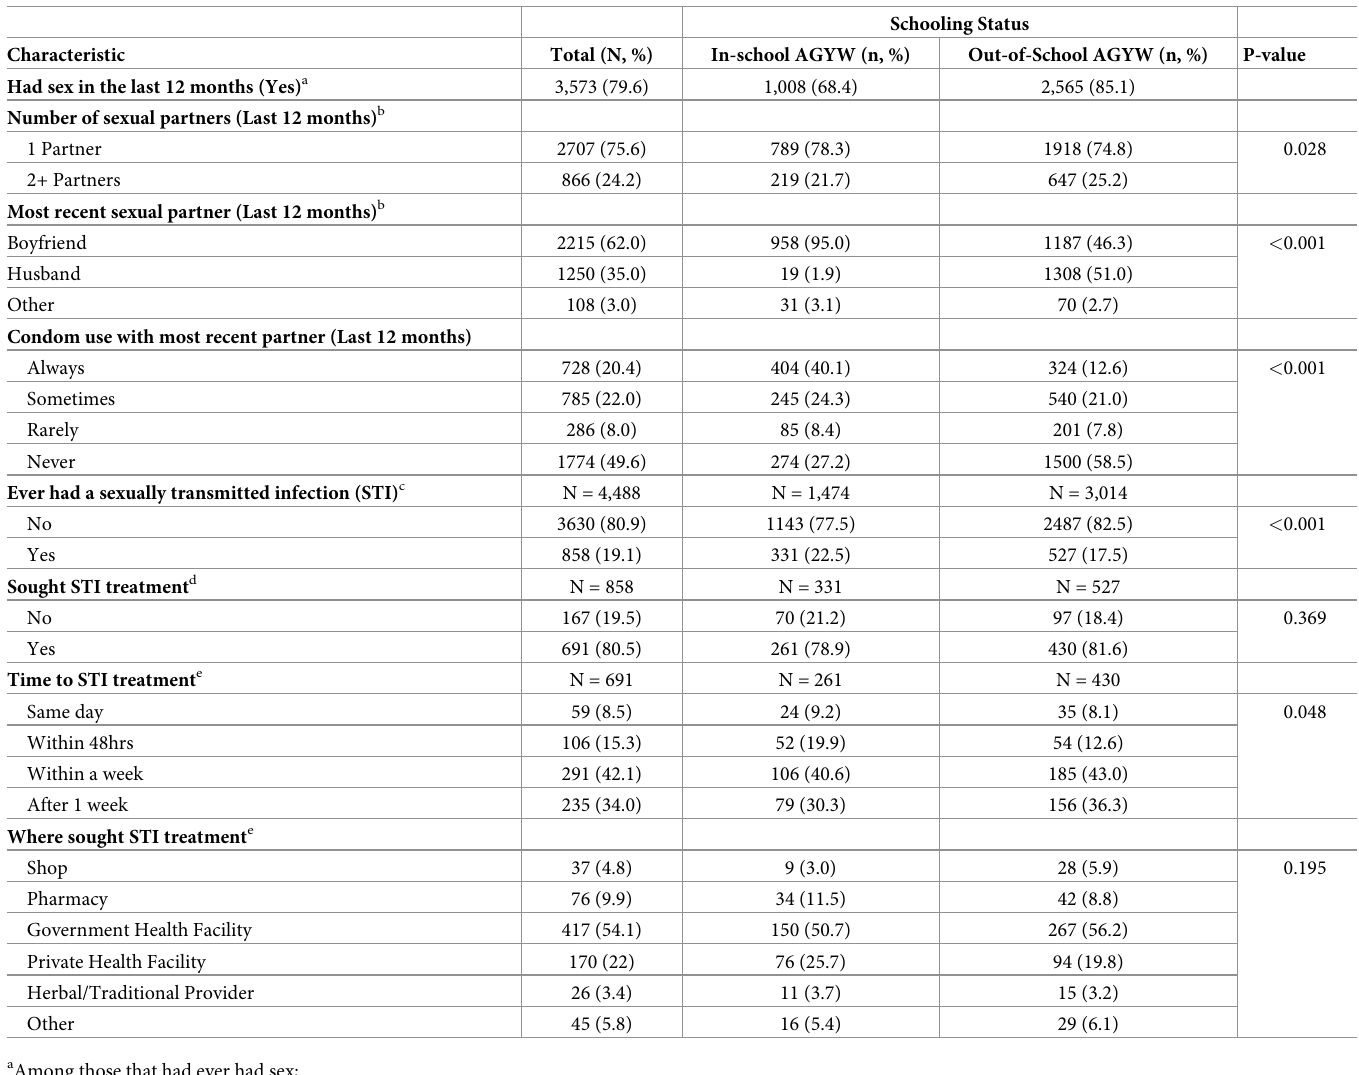
Table 3. Sexual-risk behaviors of AGYW that have ever had sex, stratified by schooling status.